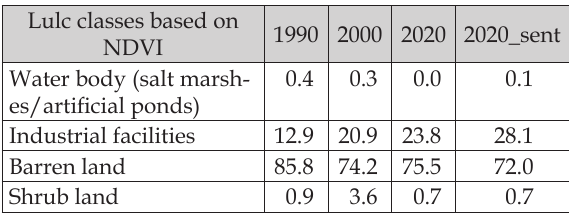
Table 3. The ratio of landscape cover elements in the territory of the Tengiz oil field according to the results of